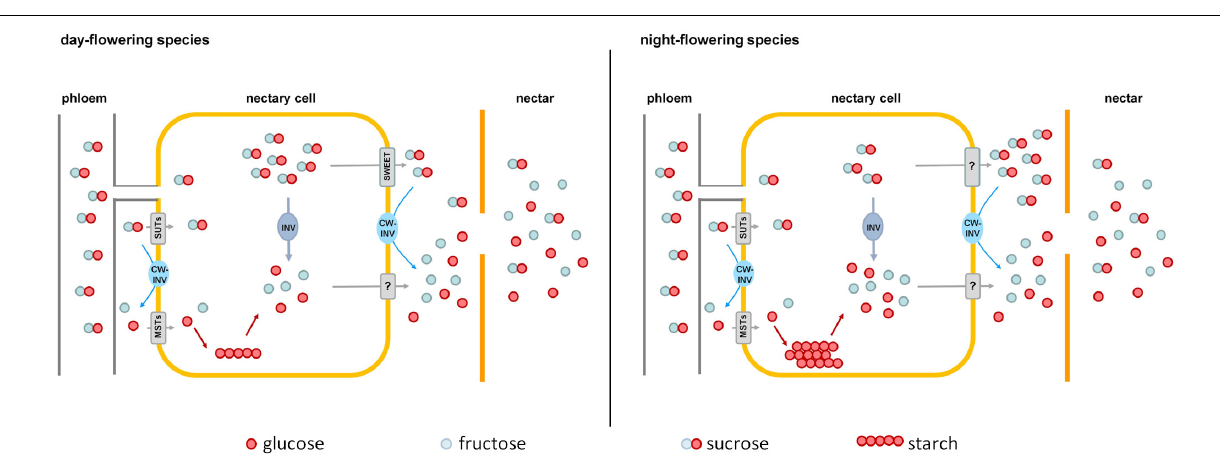
FIGURE 8 | Comparison of nectar sugar secretion in day- and night-flowering tobacco. Day-flowering species (Left) store less starch in their nectaries and contain more sucrose in the cytoplasm, which could be exported by SWEET-proteins along the concentration gradient. Night-flowering species store more starch in their nectaries and sucrose probably cannot be exported by SWEETs, since the concentration of sucrose in the cytoplasm is lower than in the nectar. In night-flowering species, sucrose cleavage within the nectaries accounts for a higher proportion of the hexose provision than cleavage during secretion, which is the opposite in day-flowering species. MSTs, monosaccharide transporters; SUTs, sucrose transporters; CW-INV, cell wall invertases; INV, invertase; SWEETs, sucrose efflux transporters; ?, unknown